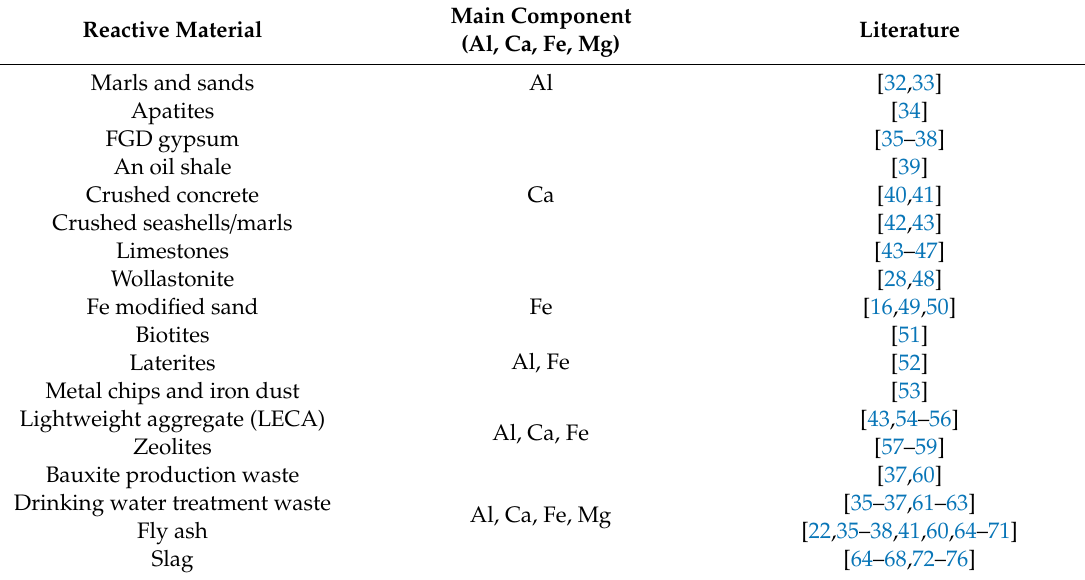
Table 2. Examples of reactive materials used for removing